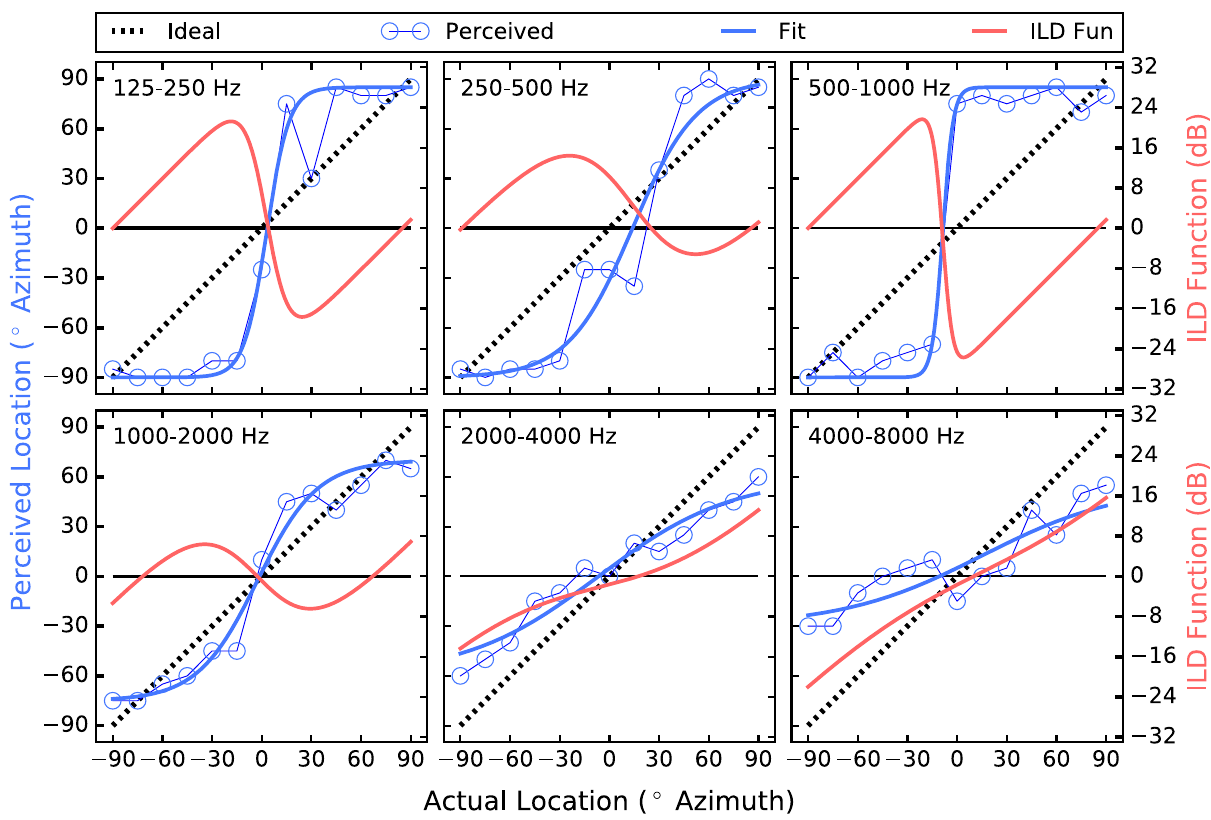
Fig 4. Corrective ILD generation data for participant 1363. The layout is identical to that of Fig 1.